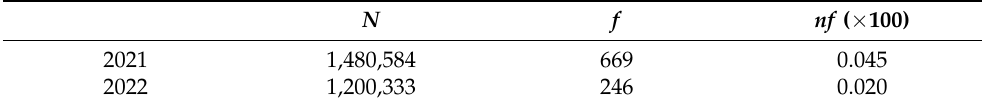
Table 3. Raw vs. normalized frequency of the central word for the two years.